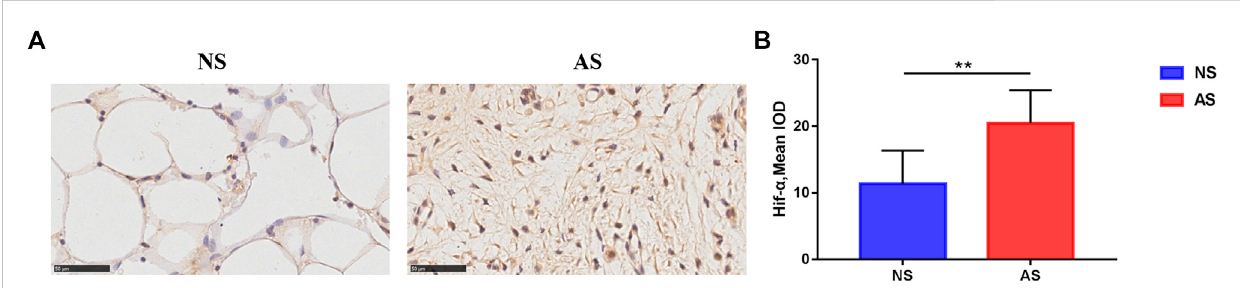
FIGURE 1 Immunohistochemistry results of tibial plateau samples. (A) Representative images of Hif-1 α expression in the NS and AS groups. Scale bars represent 500 μ m. IOD, integrated optical density. (B) Semi-quantitative analysis of Hif-1 α expression in the NS and AS groups. NS, less damaged subchondral bone; AS, severely damaged subchondral